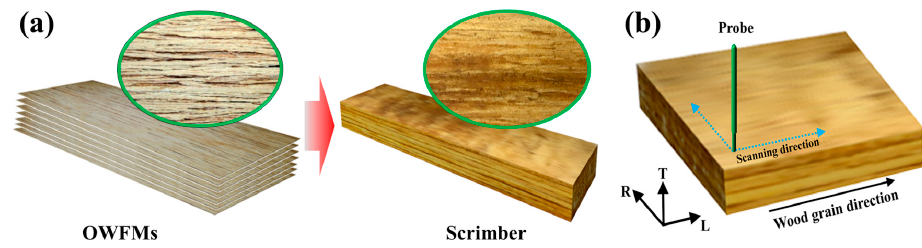
Figure 3. Schematic of ( a ) scrimber preparation and ( b ) surface roughness measurement.